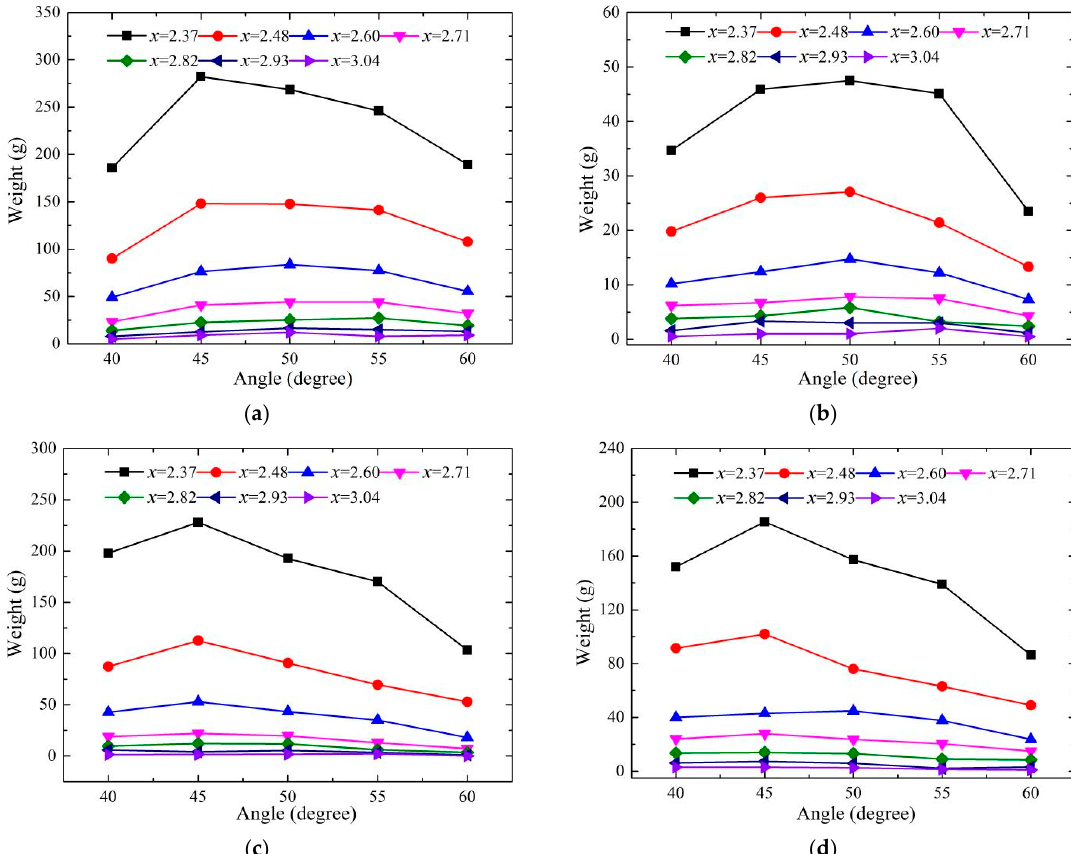
Figure 13. The distribution of the droplet weights for different bucket angles: (a) CB ( y/ Δ H = 0), (b) CB ( y/ Δ H = 0.448), (c) TB ( y/ Δ H = 0), and (d) TB ( y/ Δ H = 0.448).